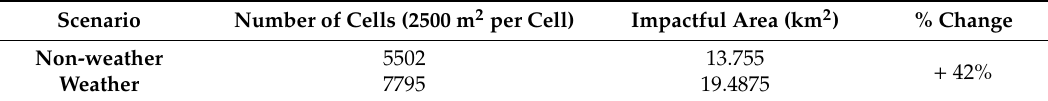
Figure 6. Impactful area based on crash hotspots. Table 3. Impactful area of crash hotspots (rural county clusters) .